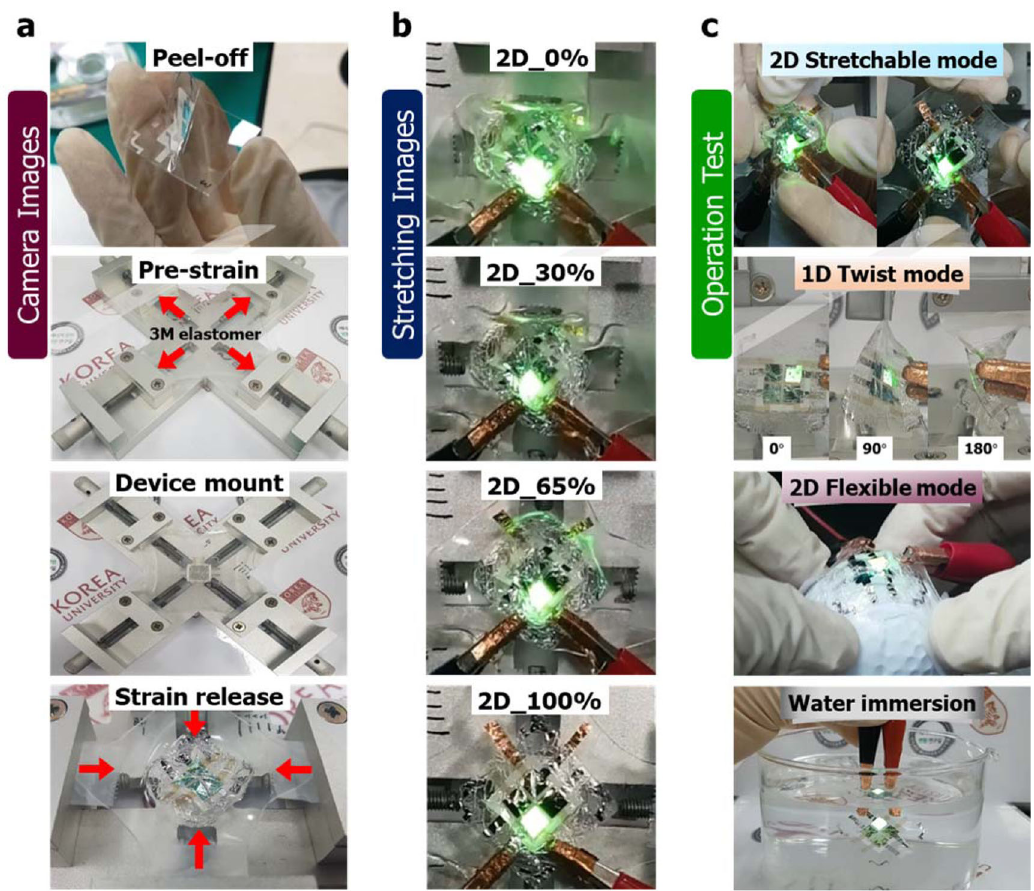
Fig. 2 Camera images of the device transfer, performance, and stability tests. a Camera images demonstrating the fabrication process of device transfer from glass substrate to a mechanically pre-strained fl exible/stretchable 3 M elastomer (clamped in the jig). b GSOLED device performance images at various two-dimensional (2D) stretch percentages (0 – 100%). c The stability and performance of GSOLED devices analyzed at 2D stretchable mode. The NPs were not incorporated in these devices. Also, the devices were one-dimensional (1D) twisted at various angles (0 – 180°) and tested in the 2D fl exible mode by attaching the device to a golf ball (standard diameter = 42.67 mm). The water immersion test was conducted. The sandwiched device structure demonstrated signi fi cant stability in liquid environments due to NOA63